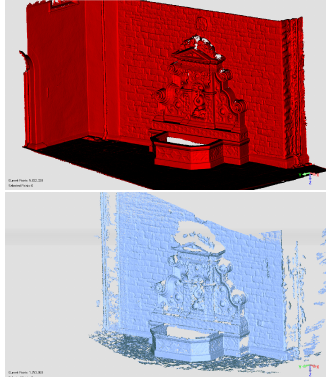
Figure 10: Fountain-P11 - Top: Laser, Bottom: